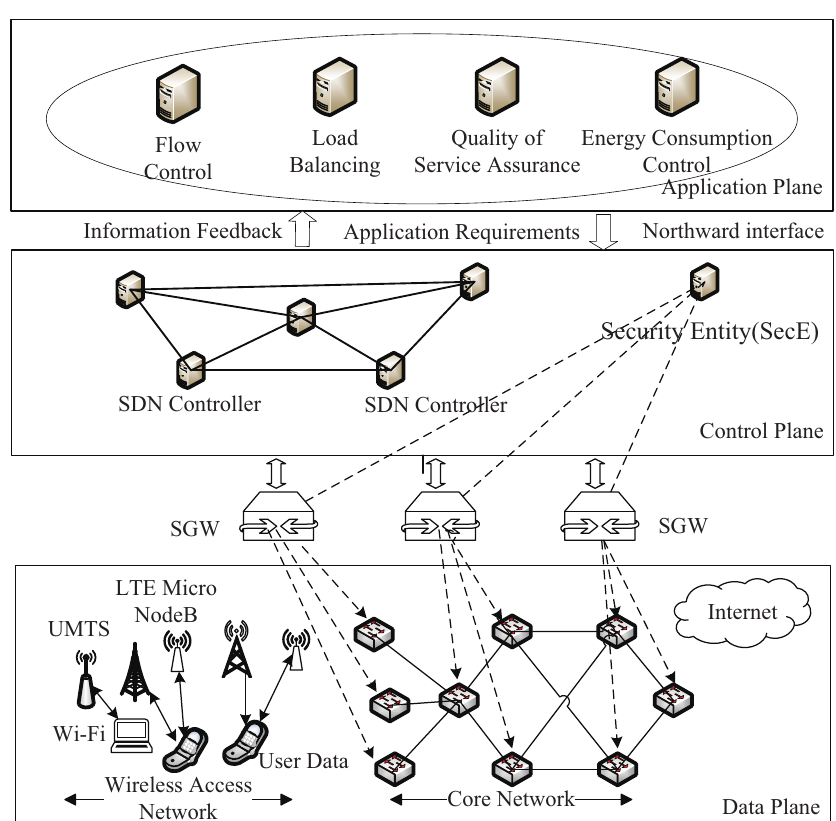
Figure 4. Robust security